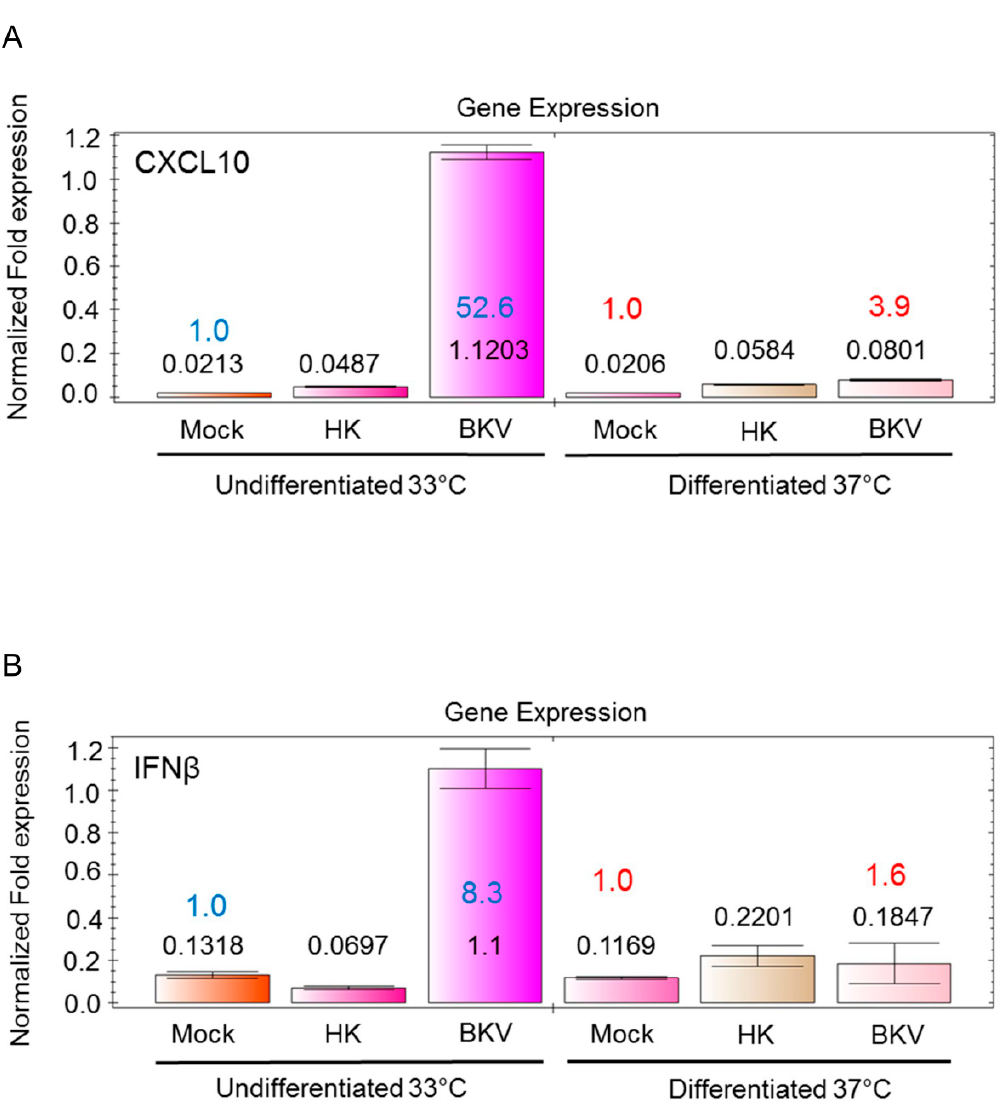
Figure 2. BKV induction of IFN β and CXCL10 transcripts in podocytes. ( A ) qRT-PCR analysis of CXCL10 transcripts in mock-infected podocytes, podocytes exposed to heat-killed (HK) BKV, and podocytes infected with wild-type BKV for 96 h. qRT-PCR analysis was performed on undi ff erentiated podocytes culture at 33 ◦ C and di ff erentiated podocytes cultured at 37 ◦ C for 7 days. qRT-PCR results were normalized to GAPDH. ( B ) qRT-PCR analysis of IFN β expression in mock-infected podocytes and podocytes exposed to heat-killed (HK) or with wild-type BKV for 96 h. Results are shown for undi ff erentiated and di ff erentiated podocytes. qRT-PCR results were normalized to